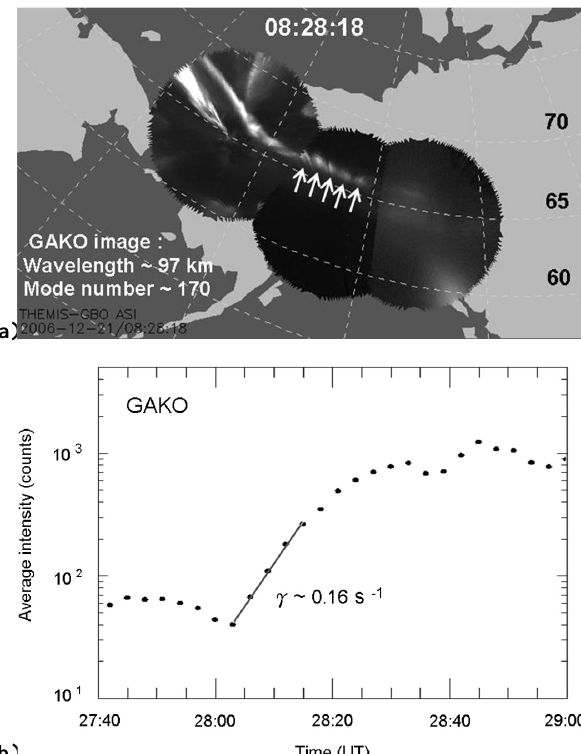
Fig. 3. (a) Auroral substorm initiation arc form appeared in the FOV of the THEMIS ground-based ASI located at KIAN for the 21 De- cember 2006 substorm event, and (b) the temporal evolution of the average arc intensity.